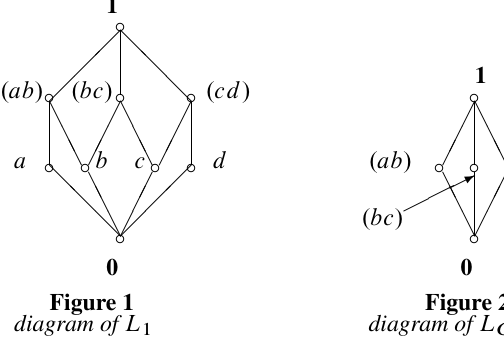
Figure 2 diagram of L Cl s .L 1 /